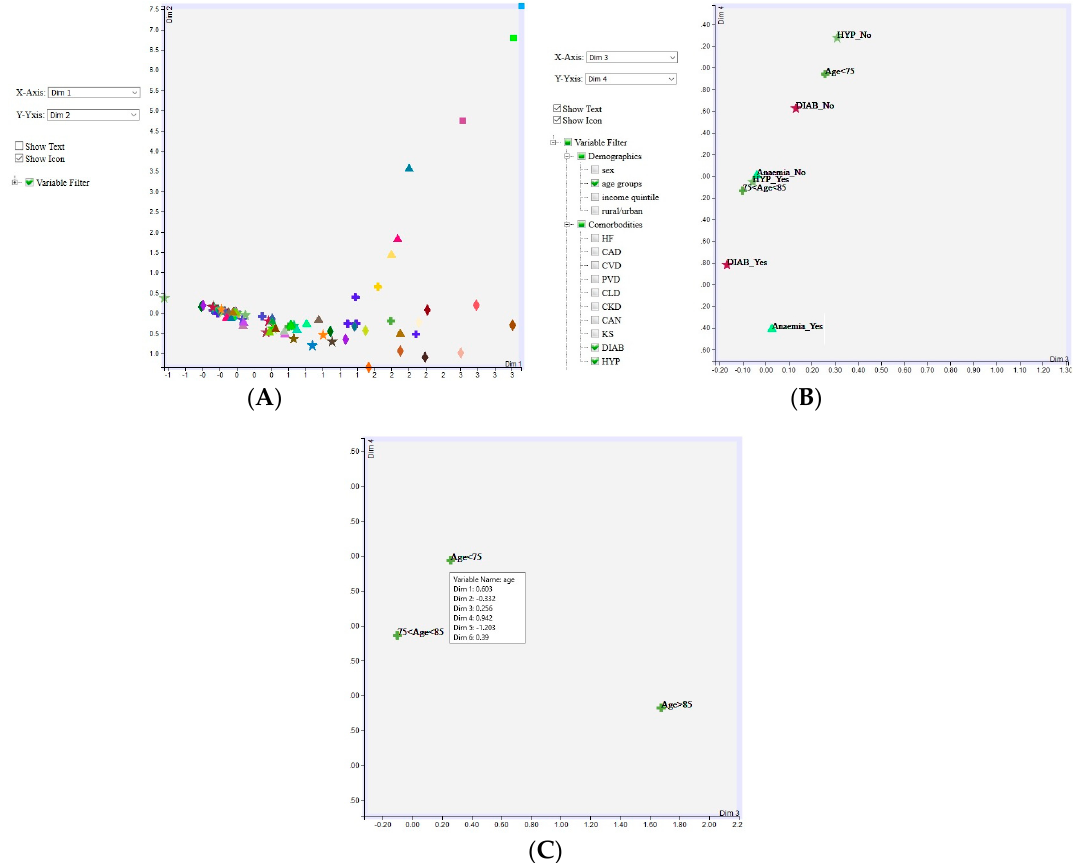
Figure 4. The raw-data subview containing ( A ) collapsible tree structure, ( B ) bar chart, and ( C ) data table.